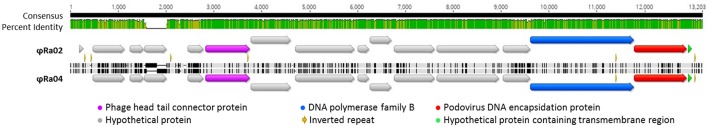
Genomes and alignment of the Ruminococcus phages ϕRa02 and ϕRa04. Predicted ORFs are depicted with arrows and putative gene products colored accordingly. The alignment was constructed using Mauve (Darling et al., 2010) and includes a consensus sequence and corresponding percentage identity graph (• 100%, • >30%, • <30%) with differences in the linear alignment of nucleotide sequences indicated with vertical shading.